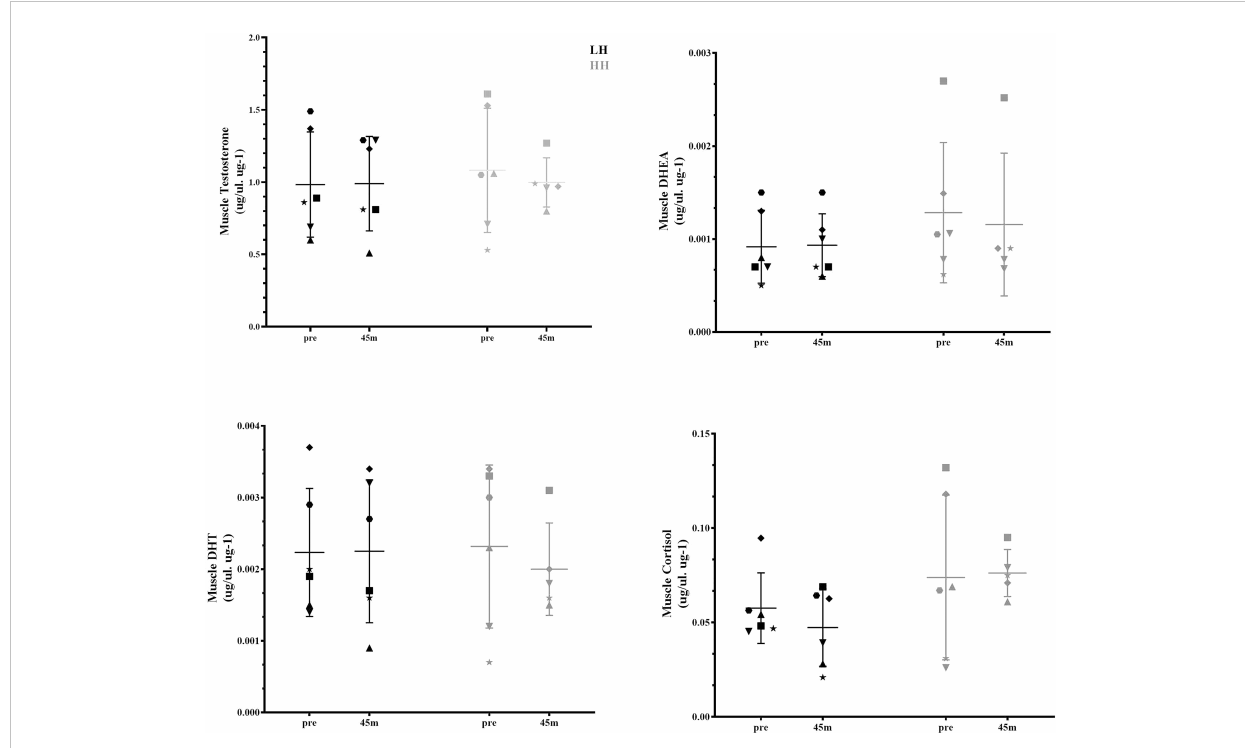
FIGURE 2 Muscle steroid hormone concentrations pre-LH and HH protocols and 45 min postexercise. Values are presented as the mean and SD. Each symbol represents one